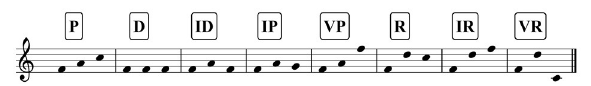
TABLE 3 | Strength at beat occurrence, for different time signatures.